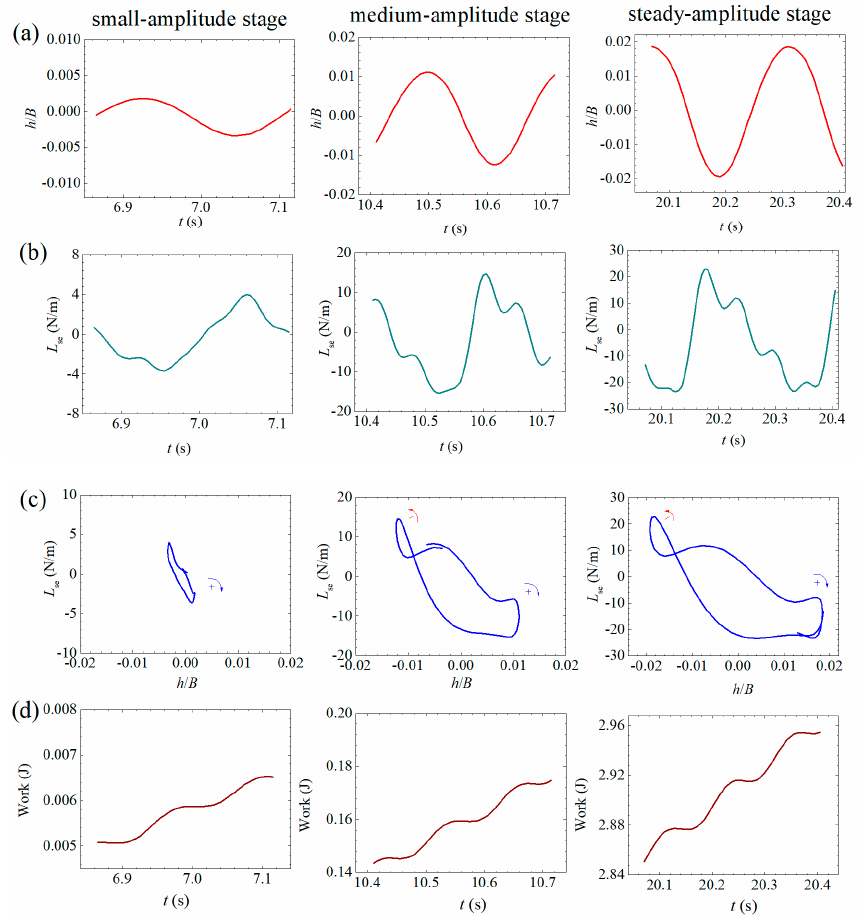
Figure 23. Evolutionary energy mechanism during a post-critical LCO in the torsional DOF (Case B1, U * = 7.785). ( a ) Torsional dispalcement; ( b ) measure of aerodynamic torsional moment; ( c ) hysteresis loops; ( d ) accumulative works.